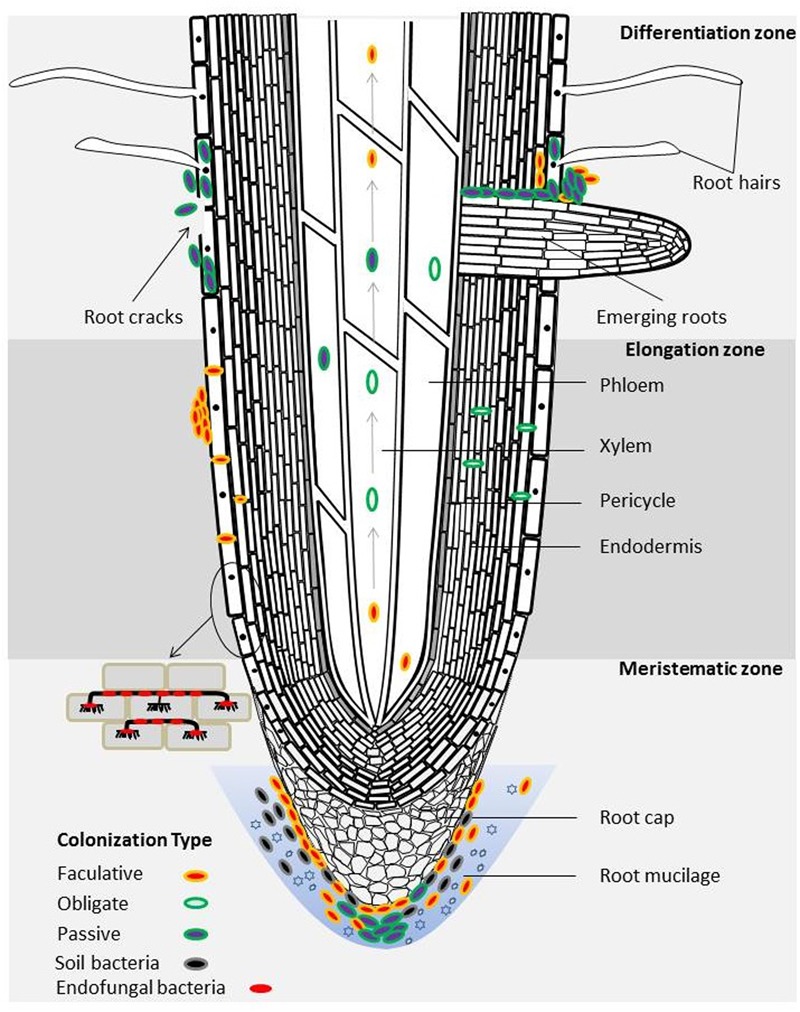
Schematic representation of the bacterial distribution and colonization patterns in the endosphere of a plant root. The emerging sites of lateral roots are among the hotspots of bacterial colonization. Arrows represent the translocation of bacteria inside the xylem and phloem. Endophytic bacteria may engage in different life styles as depicted by different colored ovals. This illustration was inspired by studies of Compant et al. (2005, 2008) and Glaeser et al. (2016).